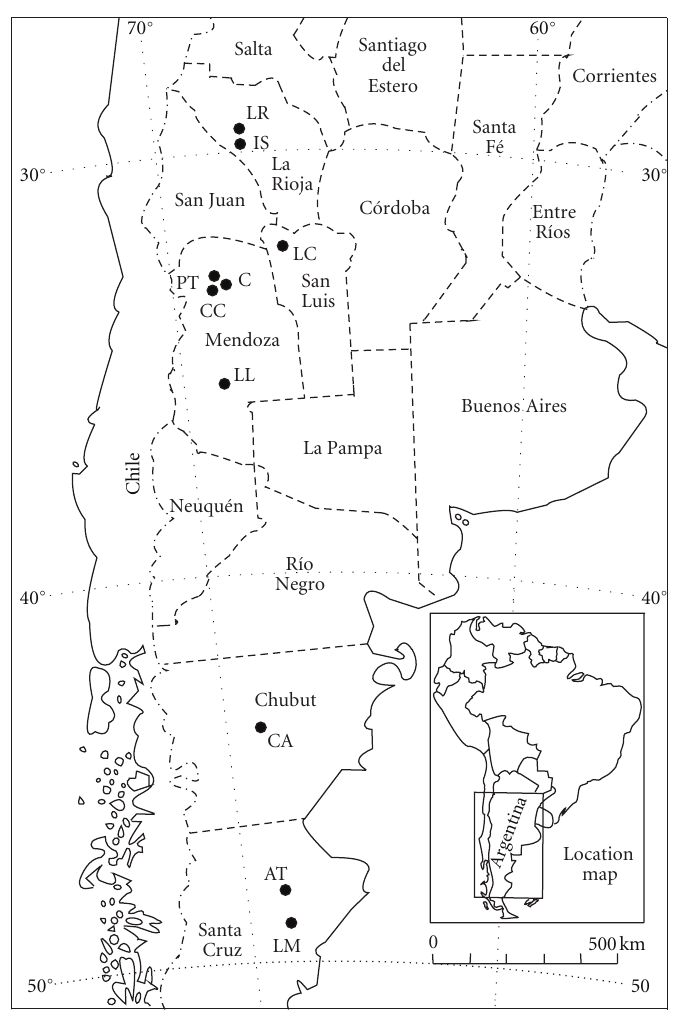
Figure 2: Map showing the Mesozoic units and outcrop areas approximately that carried the insect fauna mentioned in the text. AT: Anfiteatro de Tic´o; C: Cacheuta; CA: Ca˜nad´on Asfalto; CC: Cerro de las Cabras; IS: Ischichuca; LC: La Cantera; LL: Llantenes; LM: La Matilde; LR: Los Rastros; PT: Potrerillos. (modified from Zavattieri [38]).